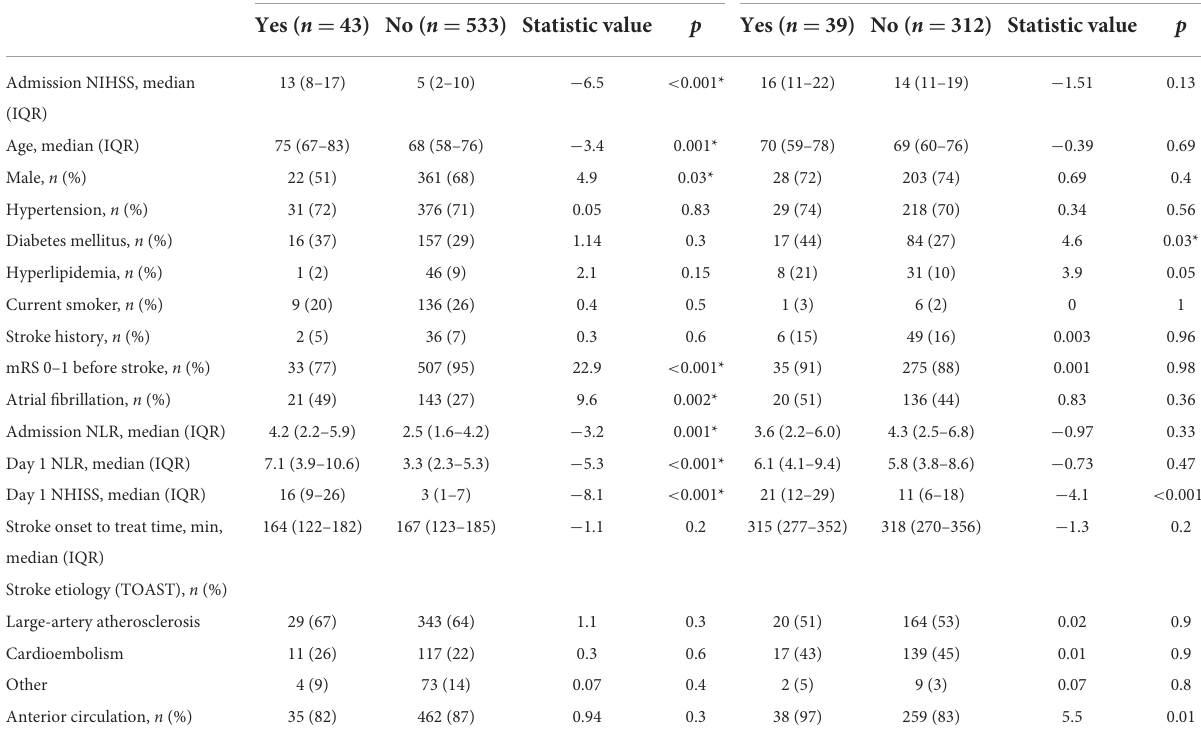
TABLE 3 Comparison of clinical characteristics and NLR in patients presented with sICH or